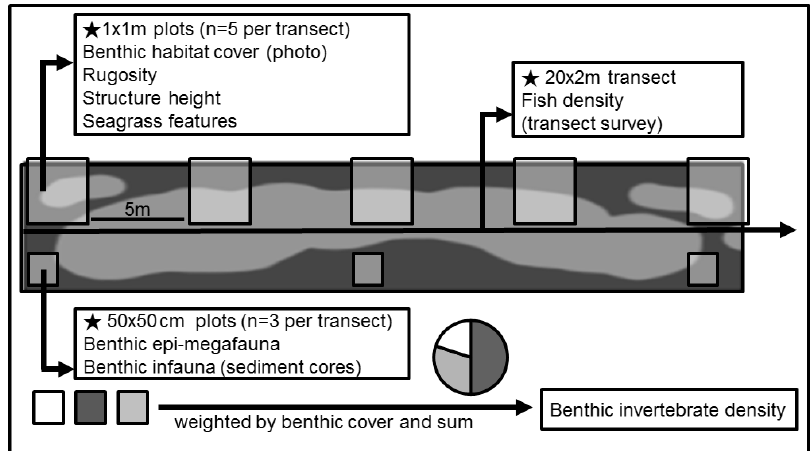
Figure 1. The location of ( a ) Dongsha Island in the South China Sea, ( b ) the study area (square inset) on the northern coast of Dongsha Island, and ( c ) the locations of the 24 study sites, which spanned seven habitat structure categories (defined in the legend).